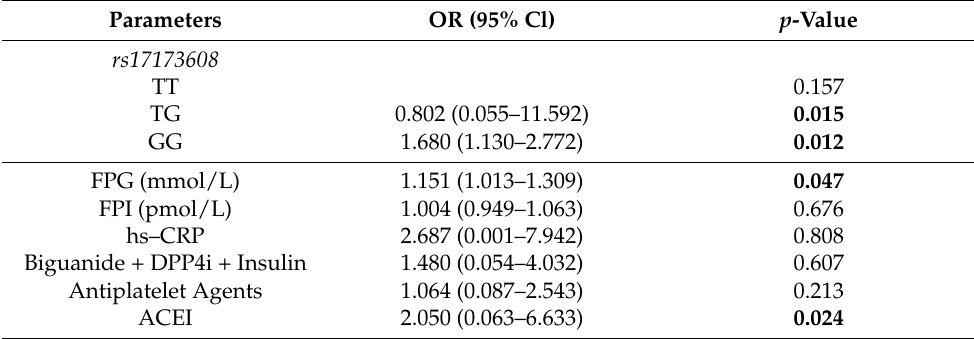
Table 5. Associations of insulin resistance in correlation with rs17173608 and clinical factors.